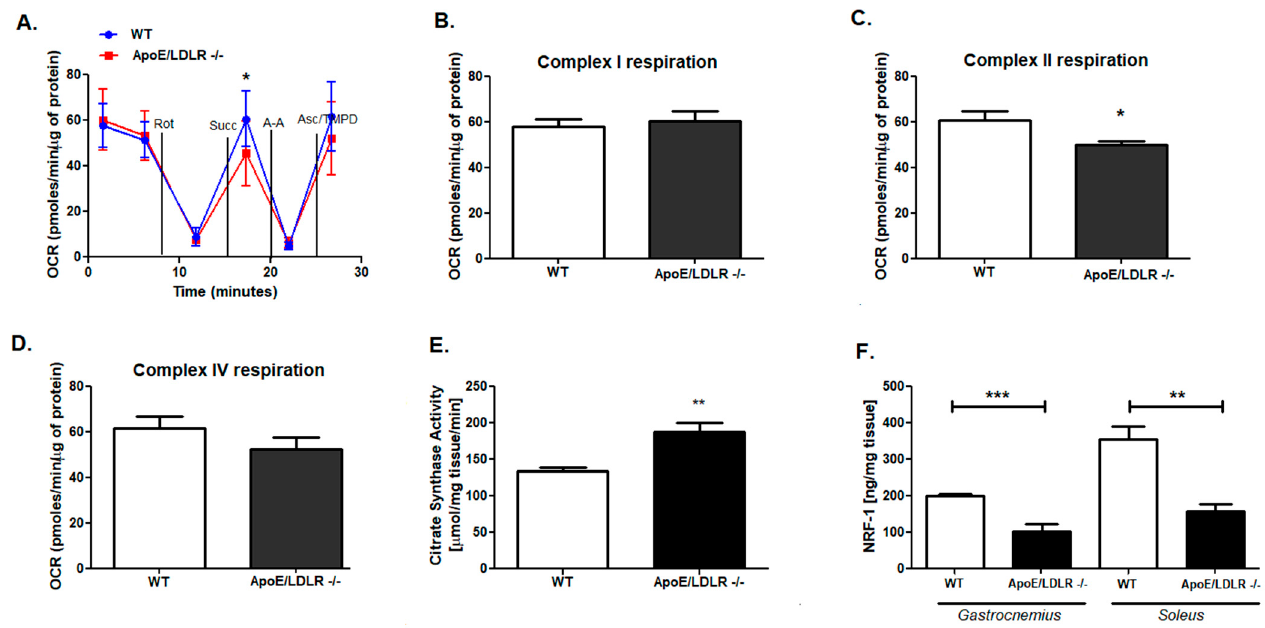
Figure 3. Increased citrate synthase activity despite accompanied derangements in mitochondrial complex II activity and nuclear respiratory factor 1 level in ApoE/LDLR -/- mice skeletal muscle. OCR data ( A ), complex I ( B ), II ( C ) and IV respiration in soleus ( D ). Mitochondrial citrate synthase activity in soleus ( E ) and nuclear respiratory factor 1 level in gastrocnemius and soleus ( F ) of WT and ApoE/LDLR -/- mice. Data presented as mean ± SEM, n = 3–7, * p < 0.05, ** p < 0.01, *** p < 0.001.